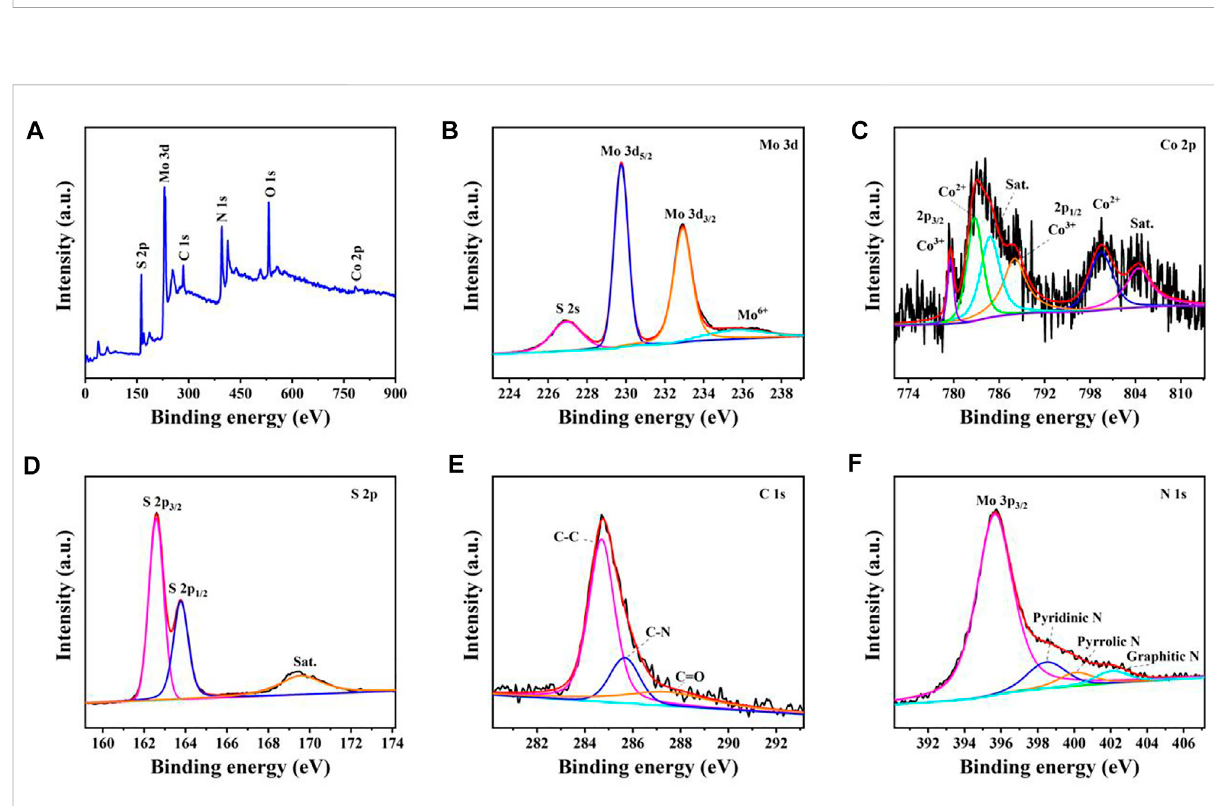
FIGURE 5 XPS spectra of MoS 2 /Co 9 S 8 /C nanohybrids: (A) survey spectrum, (B) Mo 3d, (C) Co 2p, (D) S 2p, (E) C 1s, and (F) N